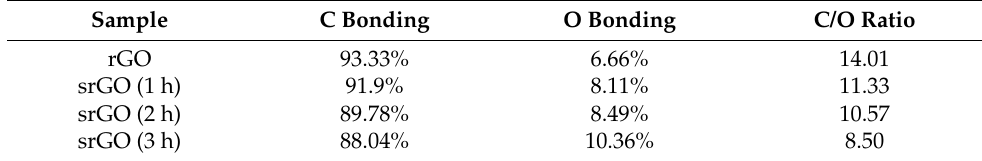
Table 2. C/O ratios of rGO and srGO calculated from XPS